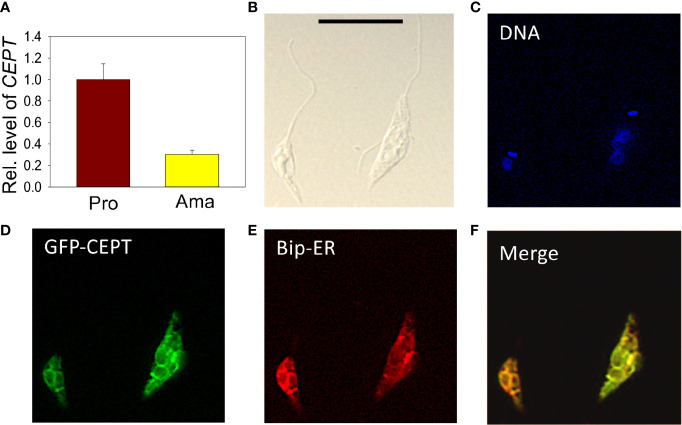
Transcript level and localization of CEPT in L. major. (A) The transcript level of CEPT was determined from culture promastigotes and lesion-derived amastigotes by qRT-PCR. The relative abundance of CEPT transcript was normalized using 28S RNA as the internal control based on ΔΔCt values. Error bars represent standard deviations from two independent biological repeats. (B–F) Log phase promastigotes of WT+pXG-GFP-CEPT were labeled with rabbit anti-T. brucei BiP antiserum followed by a goat anti-rabbit IgG-Texas Red antibody and subjected to immunofluorescence microscopy. (B) Differential interference contrast; (C) DNA staining; (D) GFP fluorescence; (E) anti-BiP staining; (F) merge of (D, E) Scale bar: 10 µm. The overlap between BiP and GFP-CEPT was determined by the JaCOP ImageJ analysis of 136 cells (
Table S1
).